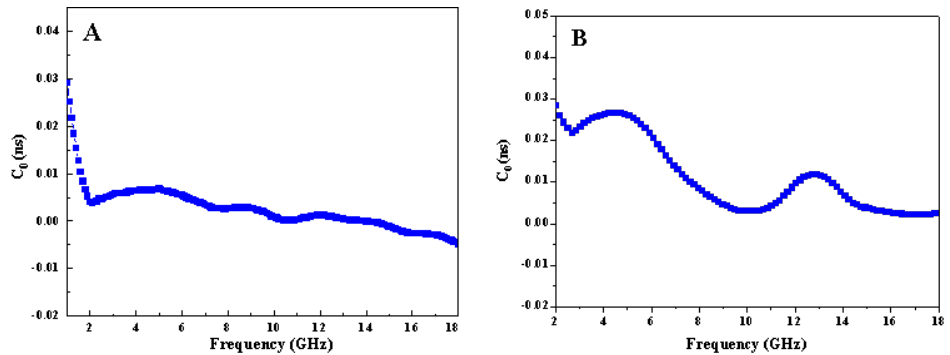
Figure 11. The frequency dependence curve of μ″(μ′) −2 f −1 of magnetic composite microspheres: Fe@C-12 ( A ) and Fe 3 O 4 @C-700 ( B ).